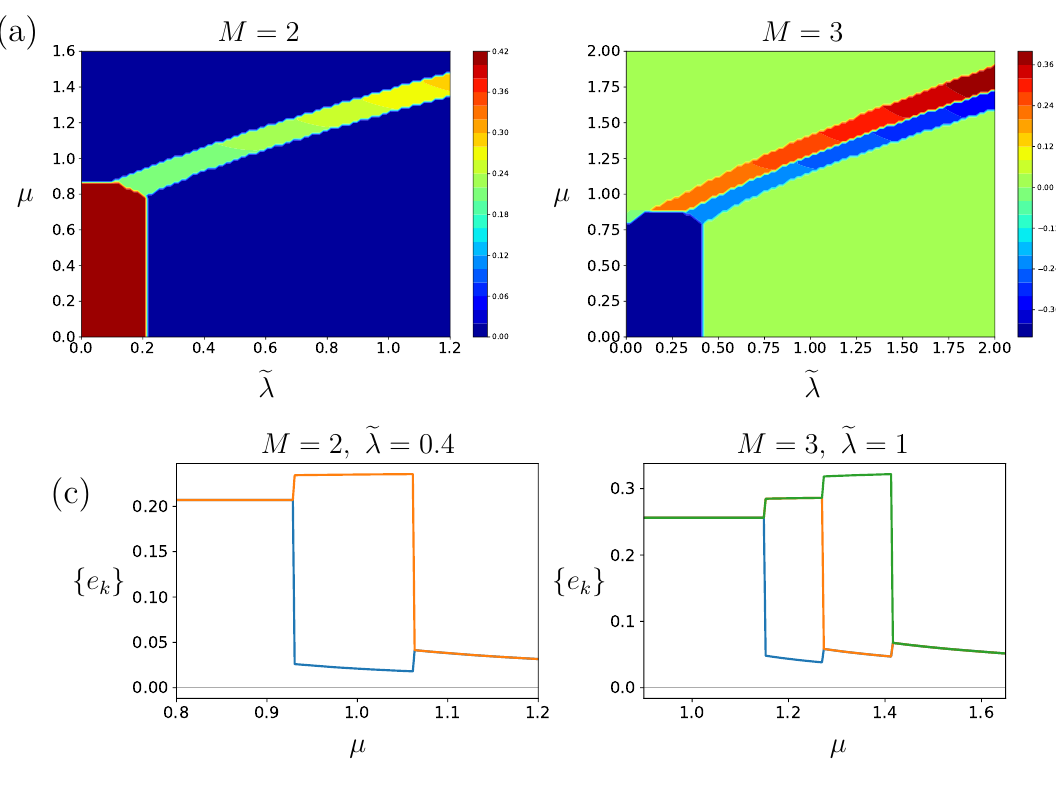
Figure 13 . The T = 0 phase diagram at nonzero chemical potential for (a) M = 2 and (b) M = 3 with g 1 = 1 and g 2 = 3 . The value plotted is | e 1 − e 2 | in (a) and e 1 − 2 e 2 + e 3 in (b) e e with e 1 ≥ e 2 ≥ e 3 assumed. All phase transitions are first order. (c) The minimum of V eff ( E ) with g 1 = 1 and g 2 = 3 at T = 0 . As the chemical potential increases, the eigenvalues drop sequentially e e through M first-order